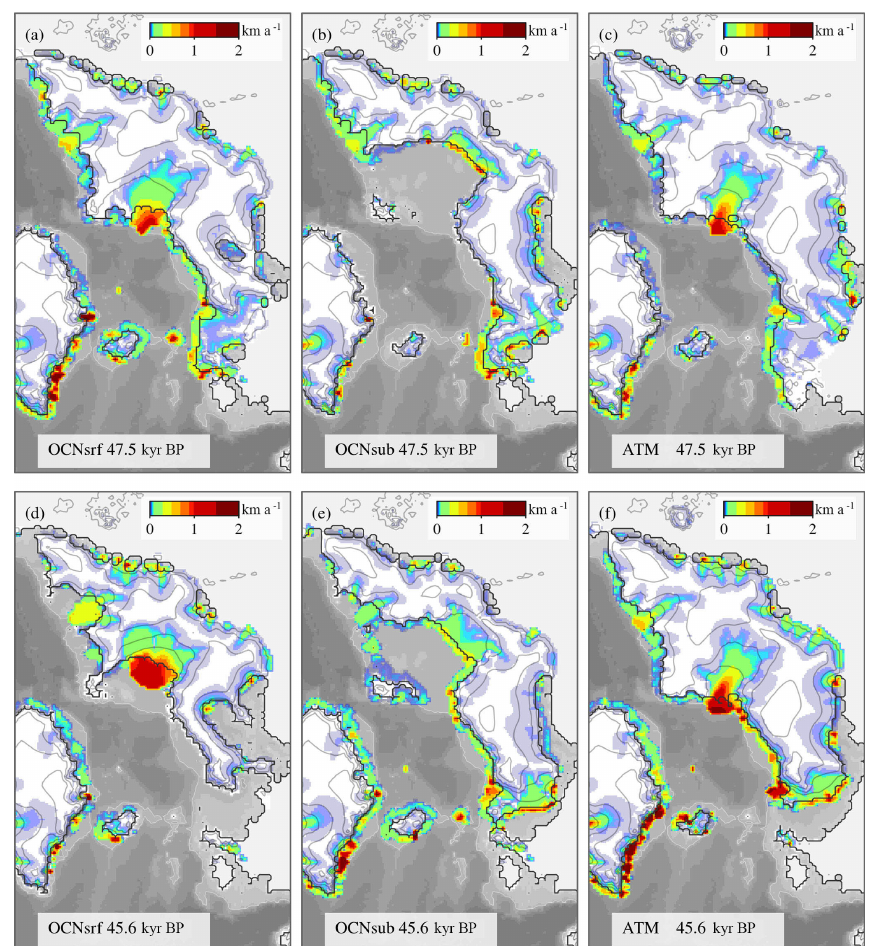
Figure 7. Simulated EIS at the end of a stadial period (a–c) and at the end of an interstadial period (d–f) for the OCN srf (a, d) , OCN sub (b, e) and ATM (c, f) experiments. Shaded colors show ice velocities (in kilometers per annum). The ice thickness contours are plotted for every 500m with the grounding-line position shown using a black line. The 500m depth contour is shown using a white line. The periods represented here corresponds to the stadial and interstadial periods prior and posterior to DO 12 (ca. 47kyrBP),